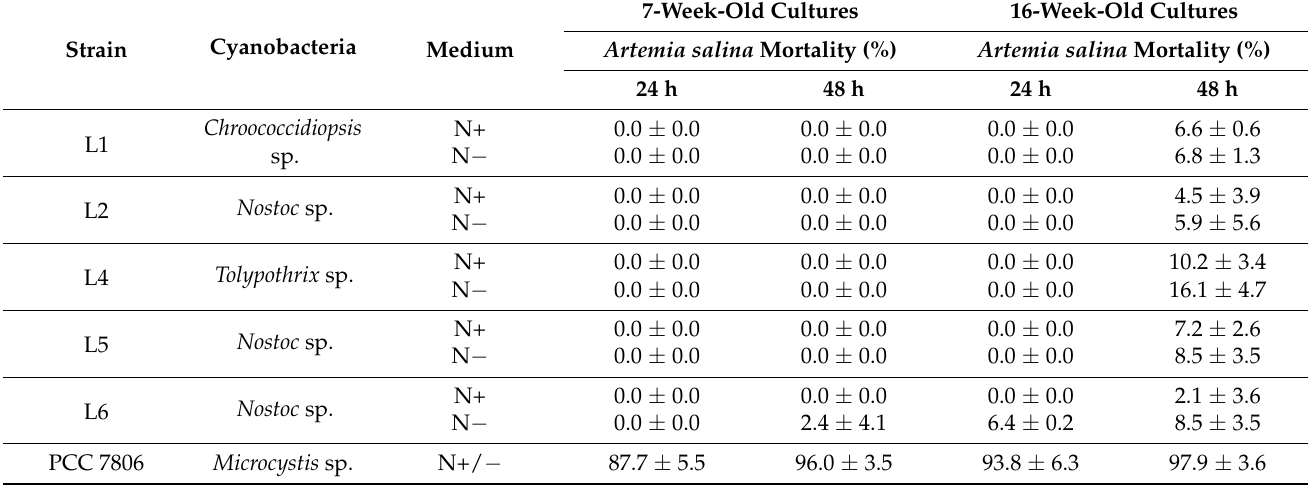
Table 1. Toxicity of isolated cyanobacterial loess strains. Artemia salina bioassay results on total toxicity of seven and 16 weeks old as a reference strain for the toxicity assessment as it is a known producer of microcystin. The strain was grown in a modified BG11 N+/ − medium (0.9 g/L NaNO 3